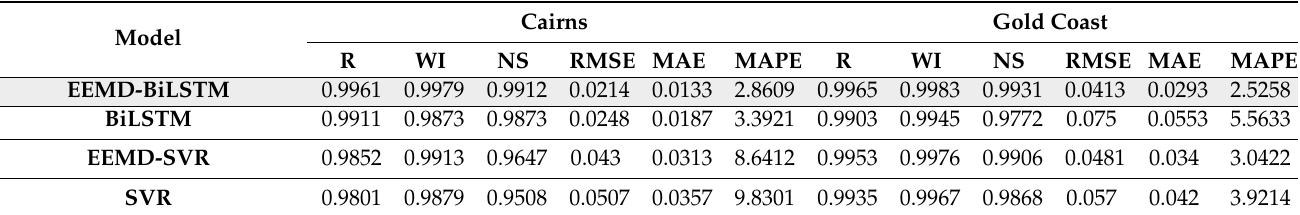
Table 7. Testing metrics results for SVR, EEMD-SVR, BiLSTM and EEMD-BiLSTM models. Model